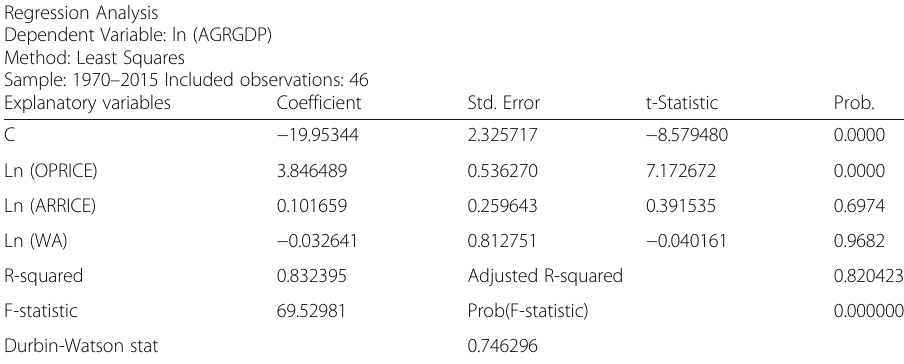
Table 4 Regression Analysis Regression Analysis Dependent Variable: ln